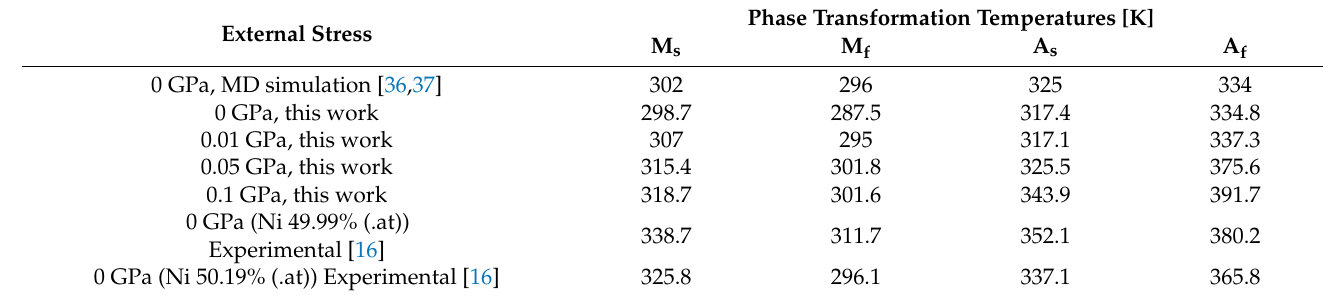
Table 1. Phase transformation temperatures from simulation results. Experimental data are included for comparison.